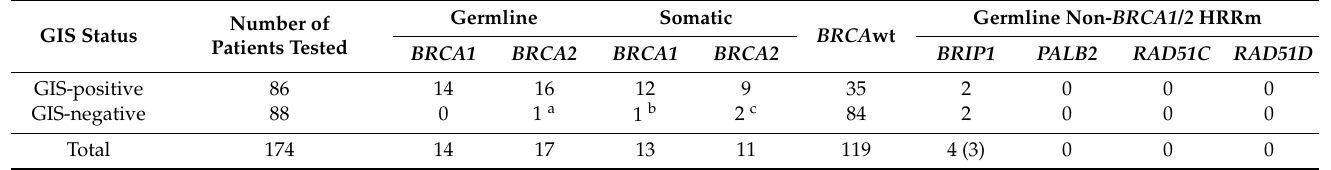
Table 5. Homologous recombination repair genes categorized by genomic instability score status. Data are presented as number (percentage; the denominator being the ‘Total BRCA wt’). Key: a BRCA2 Exon 14-16 deletion (GIS 36); b BRCA1 Exon 13-24 deletion (GIS 34); c BRCA2 c.9097dup (GIS 5) and BRCA2 c.3760G>T (GIS 24); BRCA m, BRCA1/2 pathogenic variant; BRCA wt, BRCA1/2 wild type; HRRm, homologous recombination repair pathogenic variant. GIS Status